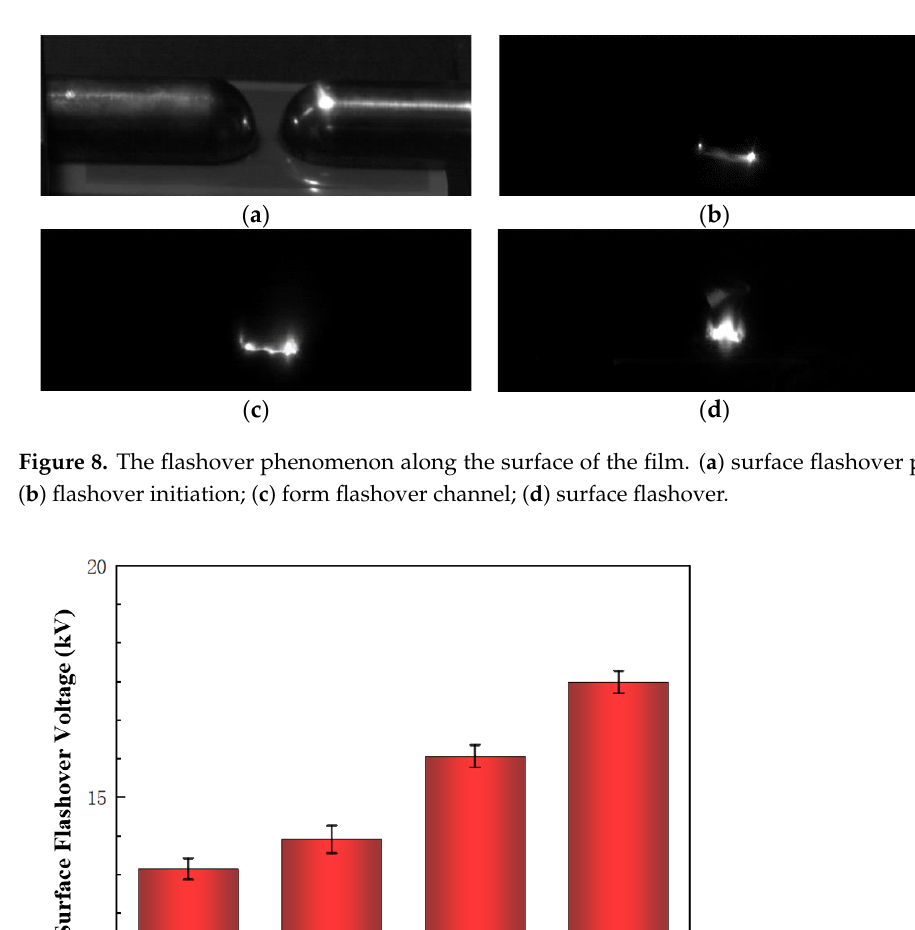
( b ) Figure 10. Resistivity of films. ( a ) Volume resistivity; ( b ) surface resistivity. In the process of material surface flashover, the ability of the material surface to bind charges will have an important influence on the process. The surface charge not only dis- torts the electric field distribution on the surface of the material but also provides seed charges when the discharge develops, resulting in a drop in the flashover voltage [26]. Appropriate reduction of surface resistivity will weaken the surface charge accumulation ability of the material, which is beneficial to accelerate the surface charge dissipation speed. As shown in Figure 10, with the increase of POSS content, the volume resistivity and surface resistivity of the composite film gradually decreased. When the POSS content was 5%, the surface resistivity of the composite film was as low as three-quarters of the pure film. As the surface resistivity of the composite film decreases, the surface charge dissipation speed of the material also increases, and the electric field is more difficult to distort, thereby increasing the flashover voltage of the composite film. In addition, the reduction of the volume resistivity of the composite films is not simply affected by the POSS content but is related to the inter-aggregate distance [27]. When the POSS content is